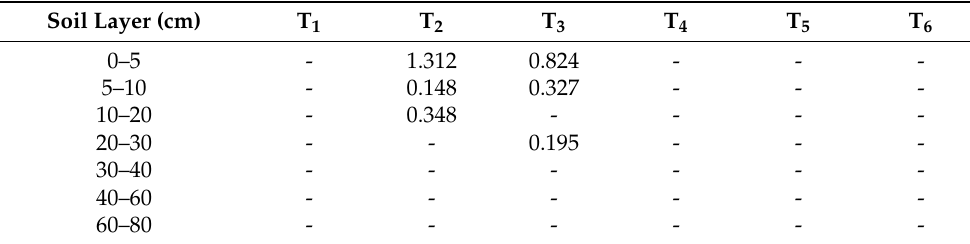
Table 4. Soil precipitation of Na 2 SO 4 · 10H 2 O (mmol/100 g) during the freeze–thaw process. Soil Layer (cm) T 1